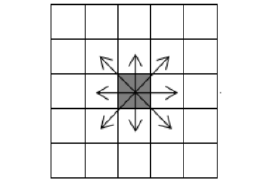
Figure 3. Moore -type cell